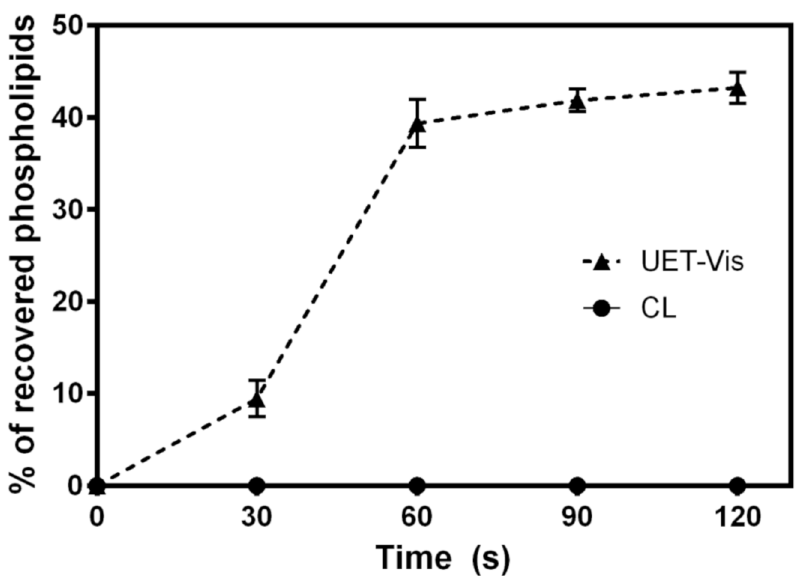
Figure 2. Profile of phospholipids’ passage through the 50 nm pore size vs. time to determine the deformability of UET-Vis. Conventional liposomes (CL) were used as a control for non-deformable formulation. Data are shown as mean ± SD ( n = 3).